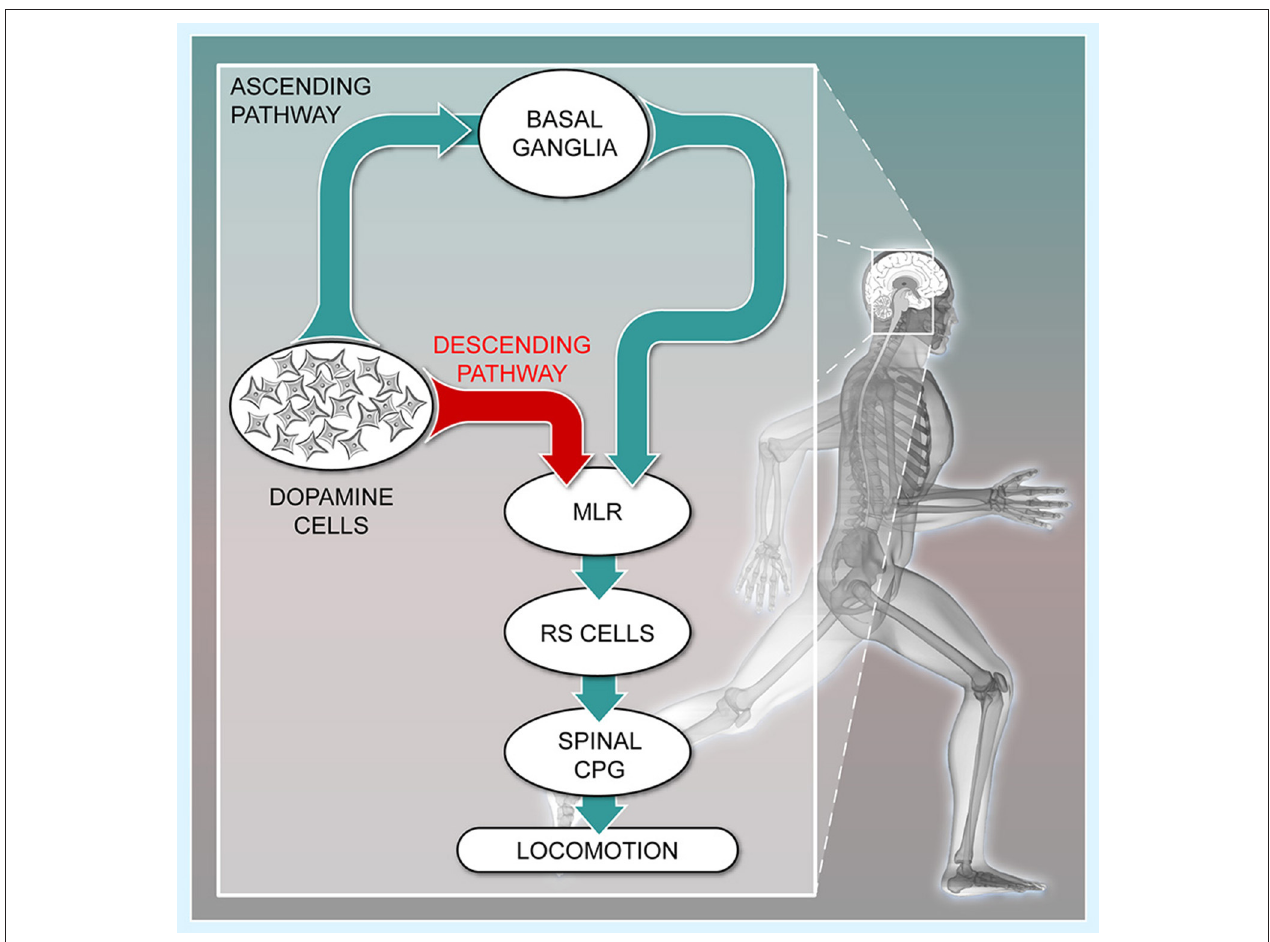
FIGURE 1 | The descending dopaminergic pathway recently uncovered in vertebrates. Schematic representation of the connectivity between the meso-diencephalic dopamine cells, the basal ganglia, the Mesencephalic Locomotor Region (MLR), the reticulospinal cells (RS), and the Central Pattern Generator (CPG) for locomotion. The meso-diencephalic dopamine cells refer to the posterior tuberculum in basal vertebrates and to the substantia nigra pars compacta in mammals. For convenience, the well-established direct and indirect pathways within the basal ganglia are not illustrated. (Adapted from (Le Ray et al., 2011). No permission is required for this